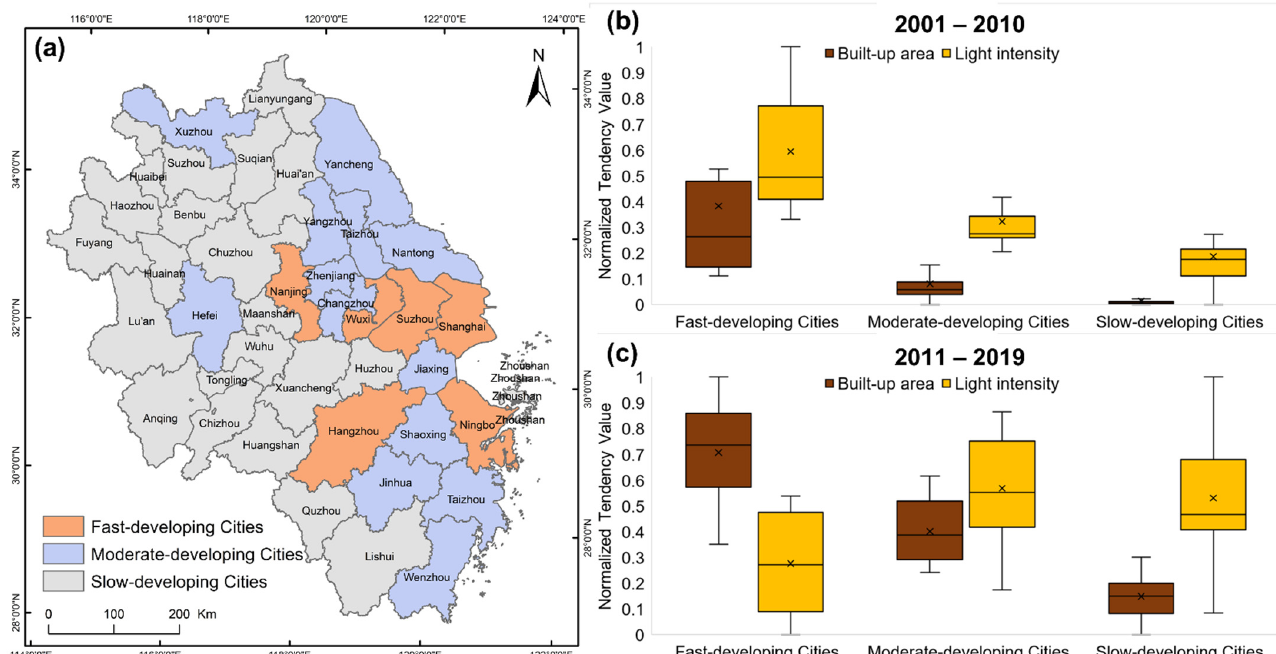
Figure 8. Based on the total gross domestic product, cities in Yangtze River Delta are divided into three regions: ( a ) the fast-, moderate-, and slow-developing cities. Statistics comparison over the three regions is calculated in terms of the tendencies of the normalized area and the nighttime light intensity between ( b ) 2001 – 2010 and ( c ) 2011 – 2019.